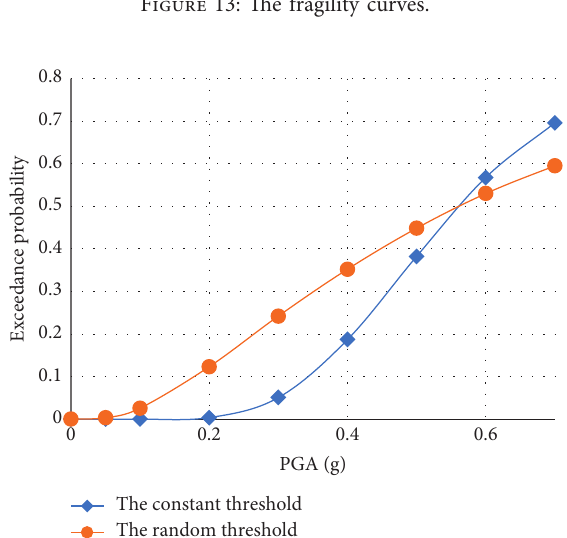
Figure 13: The fragility curves.